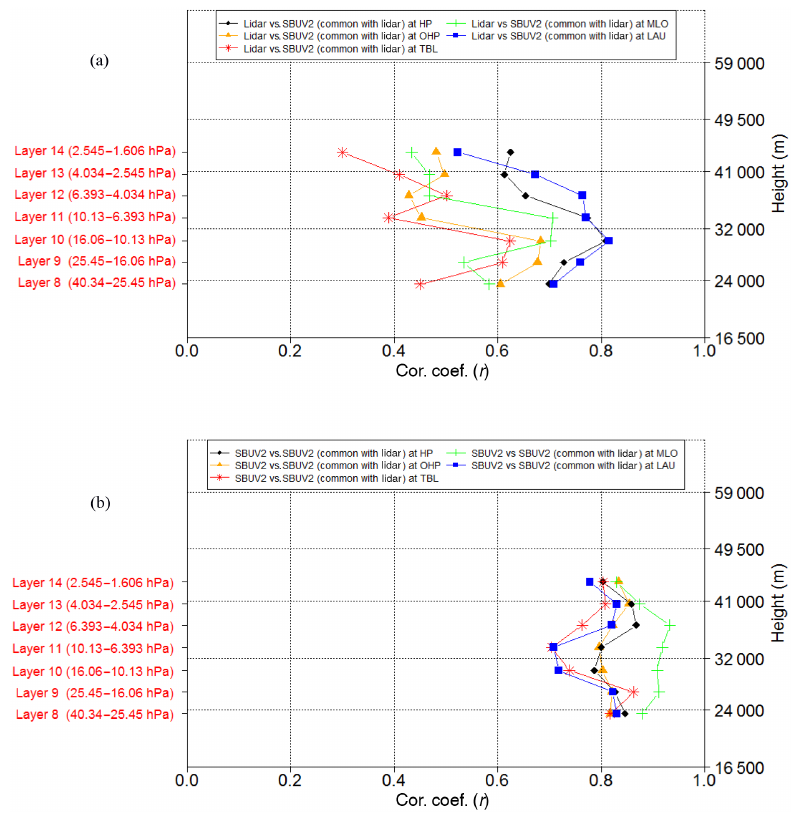
Figure 1. (a) Correlation between monthly mean ozone anomalies from lidar and SBUV station overpasses on common days. Best correla- tions are between 25 and 32km. All correlations are statistically significant at 99.99%. HP: Hohenpeißenberg, OHP: Haute Provence, TBL: Table Mountain, MLO: Mauna Loa, LAU: Lauder. (b) Same as in (a) but comparing monthly mean SBUV overpasses from about 30 days in a month with monthly mean SBUV overpasses from only days when lidar measurements were available. All correlations are statistically significant at